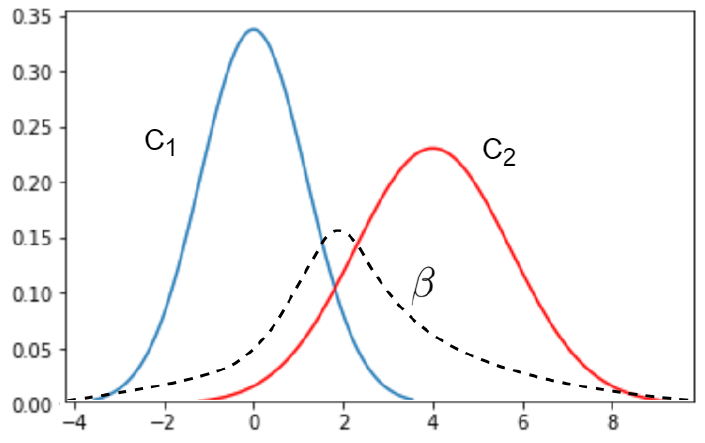
Figure 5. Posterior density plot for a binary classification with β